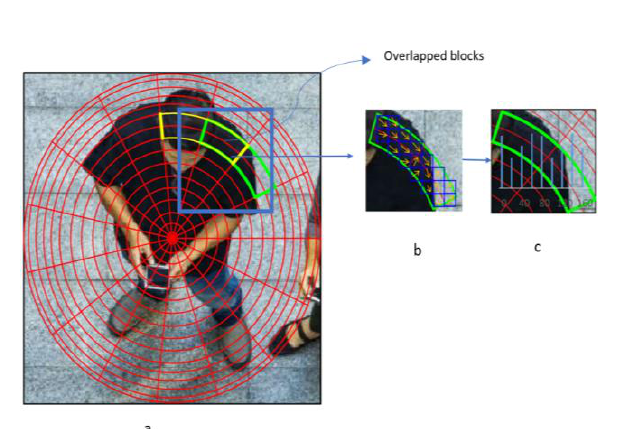
Figure 3. a) spatial configurations in SRHOG, b) gradient